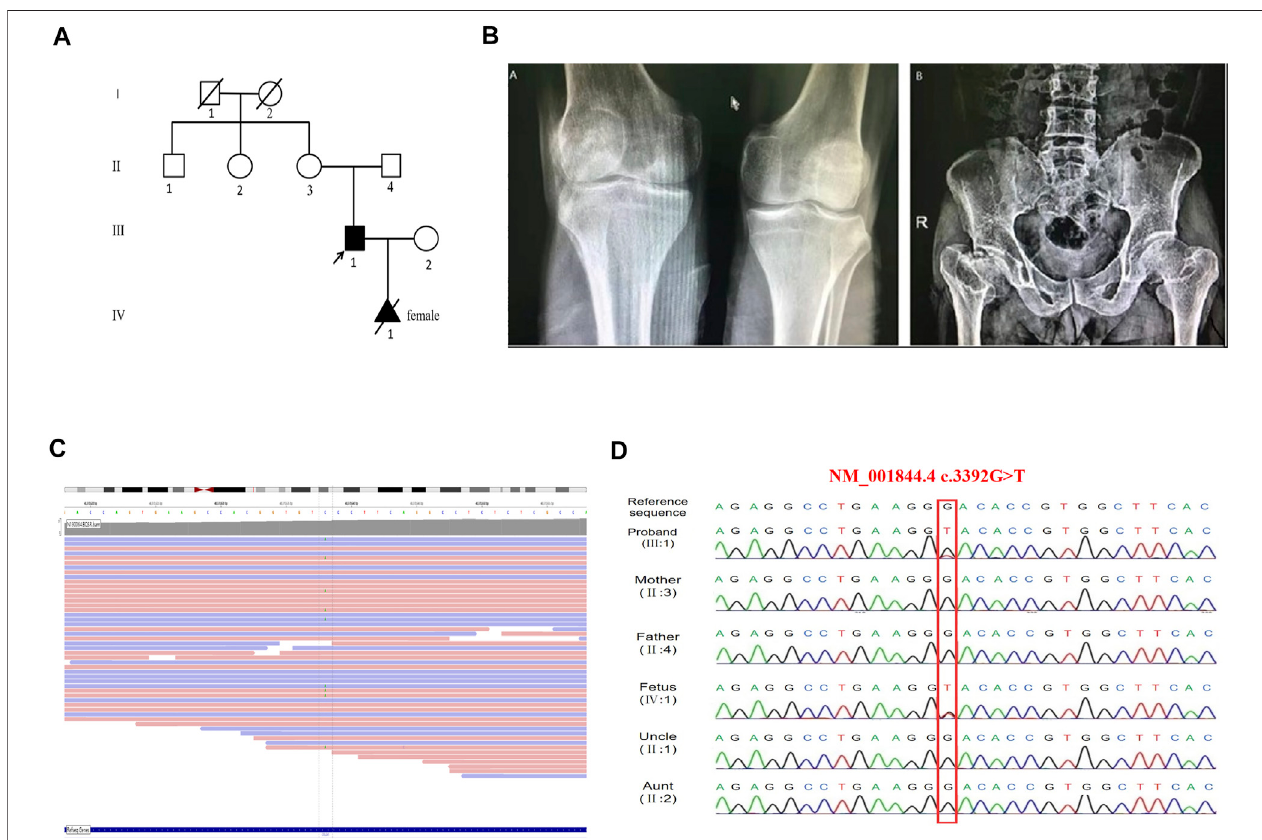
FIGURE1| Featureoftheprobandandthe COL2A1 mutationinthisfamily. (A) Thepedigreeoftheproband. (B) Radiographsoftheproband.Thelowerfemurand the upper tibia are fl attened and narrowed (left panel), the bilateral femoral heads are fl attened, and the femoral neck is shortened (right panel). (C) Screenshot of the IntegrativeGenomics Viewer. Alternativeallelesat COL2A1 c.3392positionaremarked.Thetotal depthofsequencingcoverage atthispositionwas44reads. Theallele frequency was 20% of tatal depth corresponding to the ref/alt was 35/9, suggesting mosaicism. (D) The Targeted next-generation sequencing and Sanger sequencing showed the proband and fetus carring the same mutation of c.3392G >